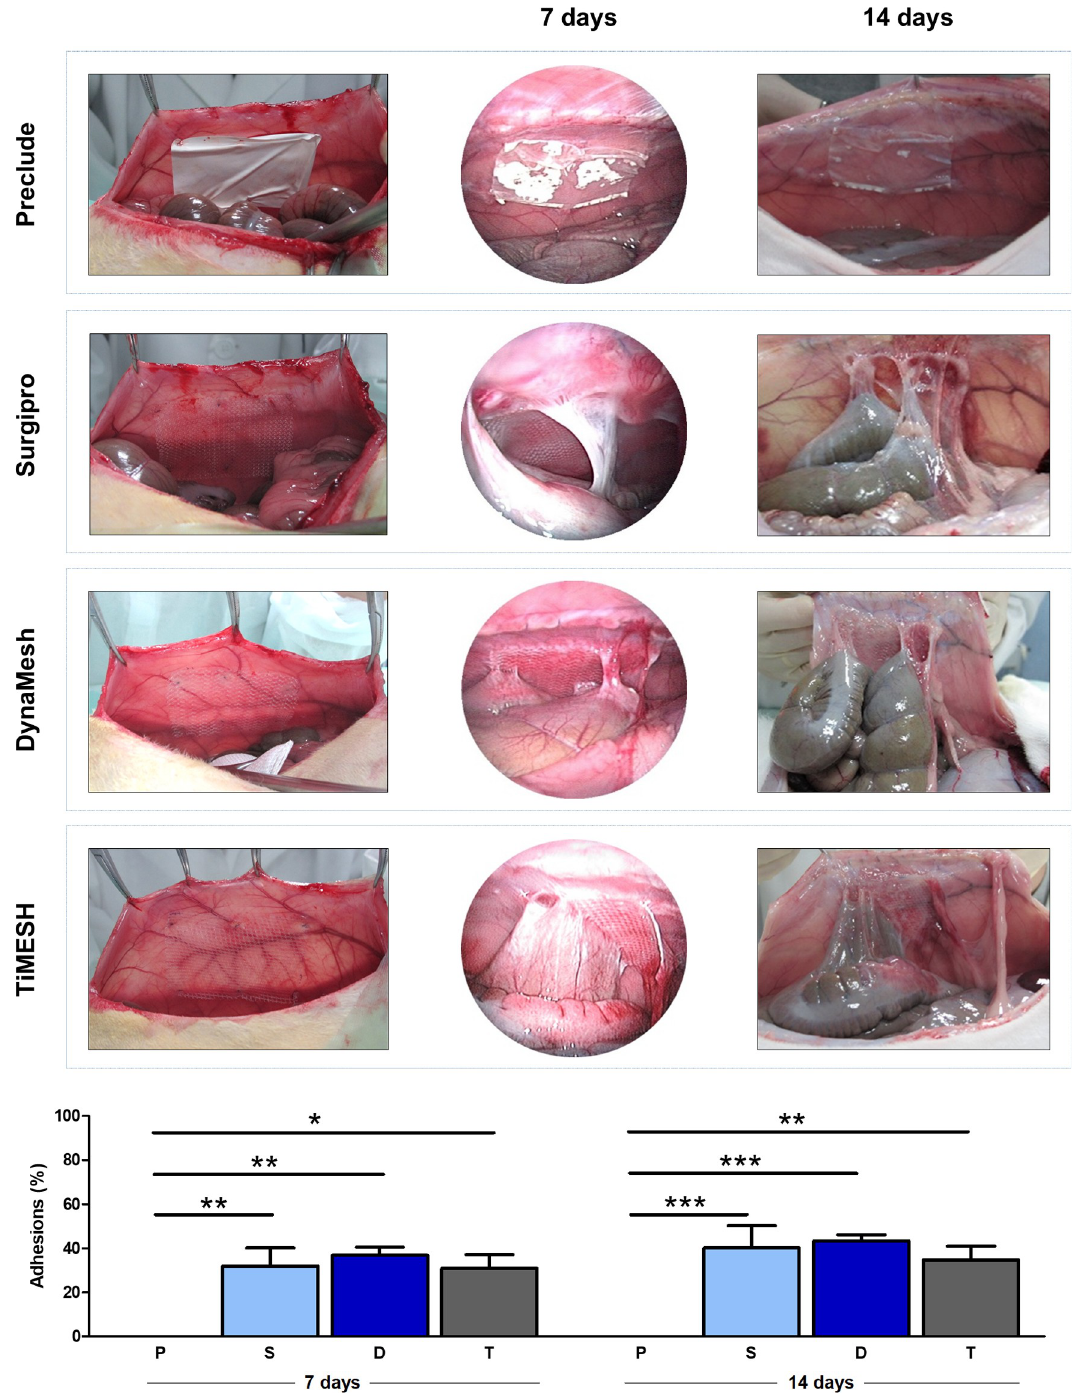
Fig 4. Surgical technique, laparoscopy and adhesion formation. Macroscopic appearance of the meshes after implantation and laparoscopic analysis in the different experimental groups: Preclude (P, laminar e-PTFE); Surgipro (S, bare reticular PP alone) and the two hybrid reticular meshes: DynaMesh (D, PP interwoven with PVDF) and TiMESH (T, PP coated with titanium). Percentage of the mesh areas covered by adhesions for each experimental group at 7 and 14 days post-implantation are shown. Reticular meshes (Surgipro, DynaMesh and TiMESH) showed no differences between each other at any study time point, but differences were significantly higher for all of them compared to the laminar Preclude ( � p < 0.05, �� p < 0.01, ��� p < 0.001).